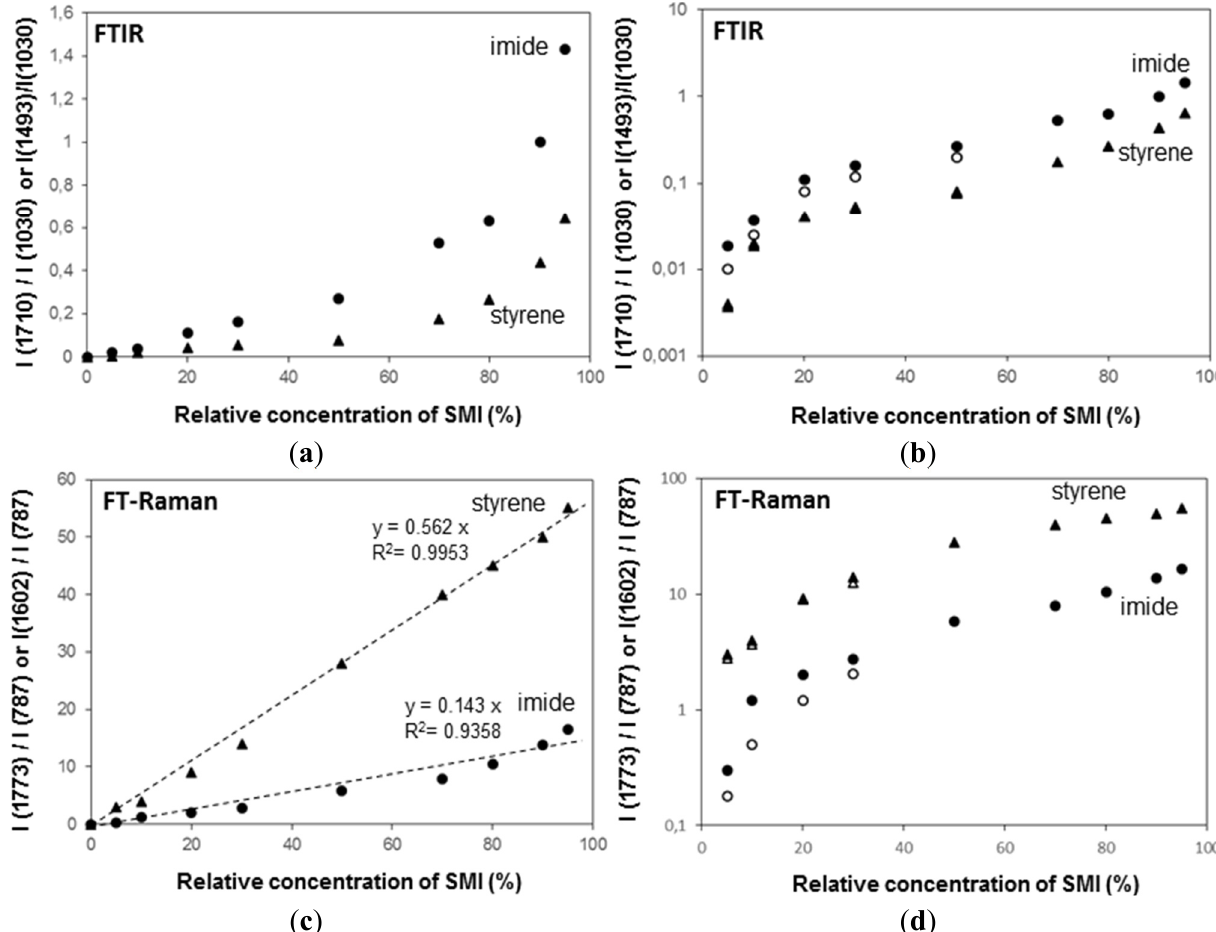
Figure 11. Concentration effects and quantification of band intensity ratios imide/kaolinite ( ● , ○ ), and styrene/kaolinite ( ▲ , ○ ) from ( a , b ) from FTIR spectra, ( c , d ) FT-Raman spectra for physically mixed Kln/SMI (closed symbols) and chemically reacted Kln/SMI (open symbols), the chemically reacted Kln/SMI only for concentration ratios up to